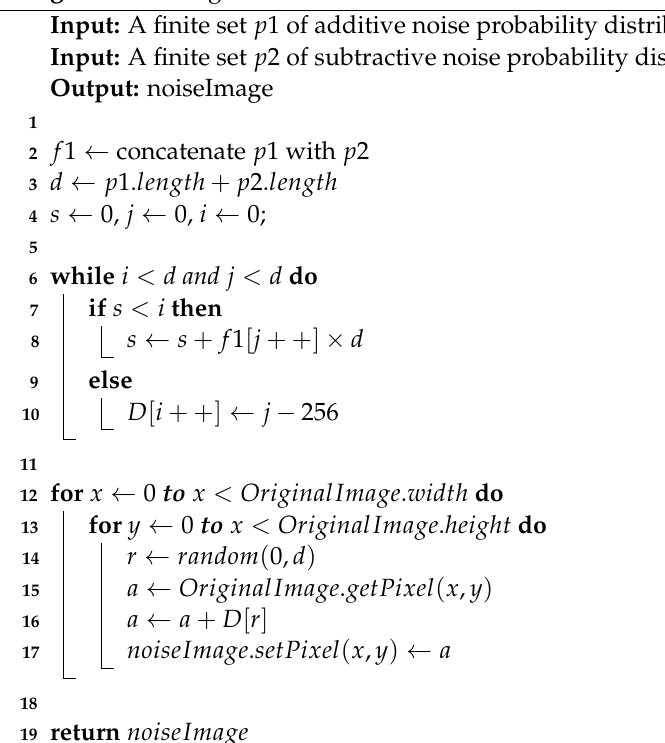
Algorithm 6 image with simulated mixed